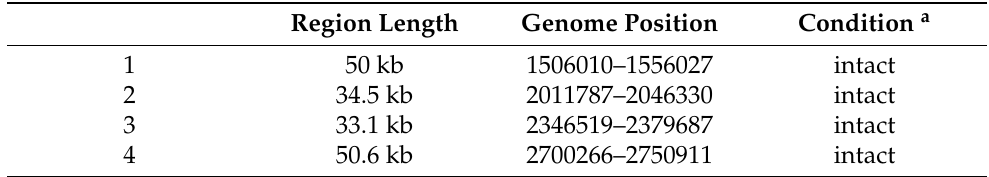
Table 4. Localization of the prophages identified in the genome of K. pneumoniae kp52145. Number 2 corresponds with the over-represented region in evolved